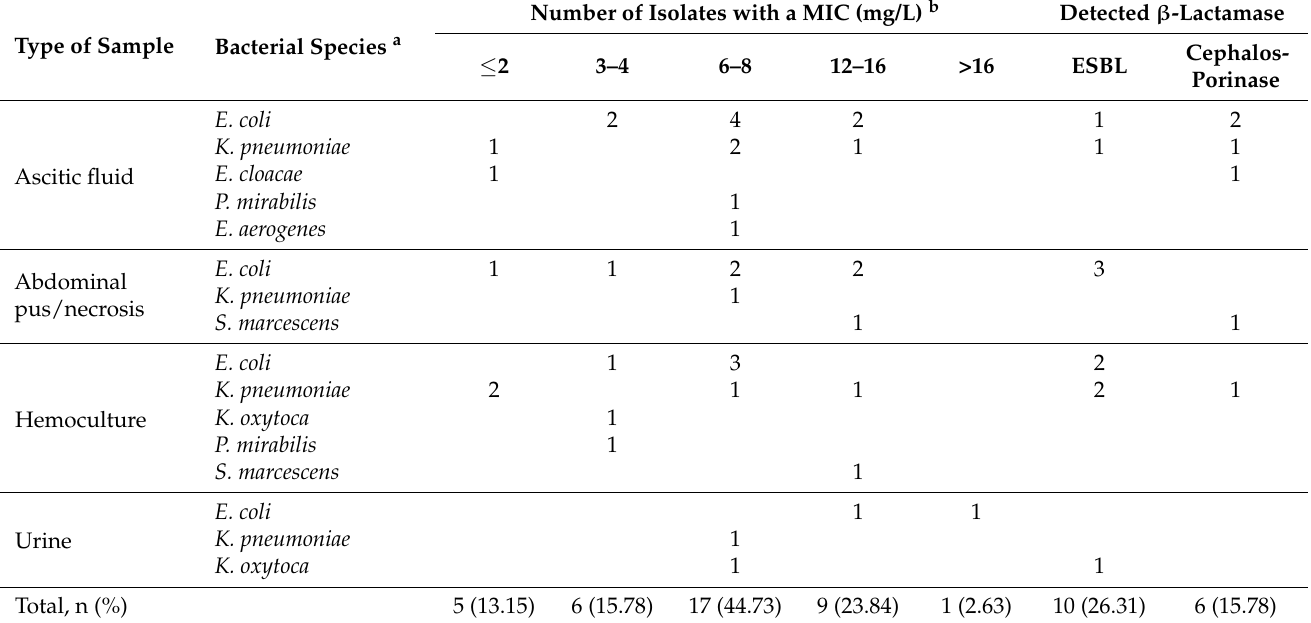
Table 2. Microbiological